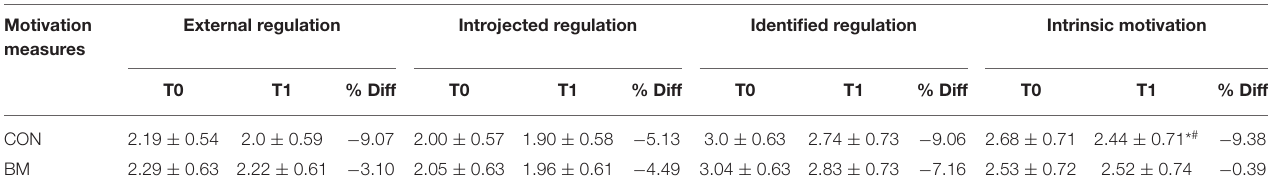
TABLE 3 | Motivation score from SRQ-A questionnaire from T0 and T1 for classroom-based mathematics for the two intervention groups (CON and